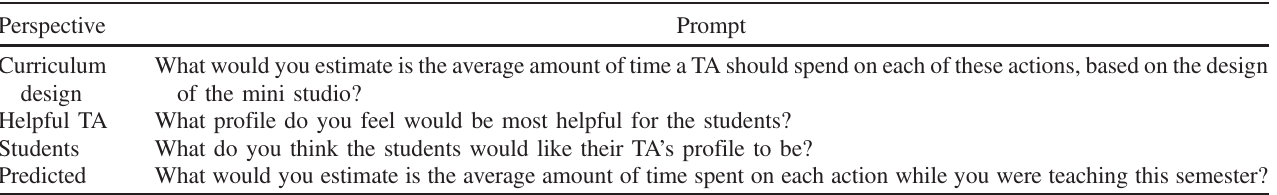
TABLE II. The prompts for the TA profile perspectives that the TAs needed to fill in as given in the interviews. Perspective Prompt Curriculum design